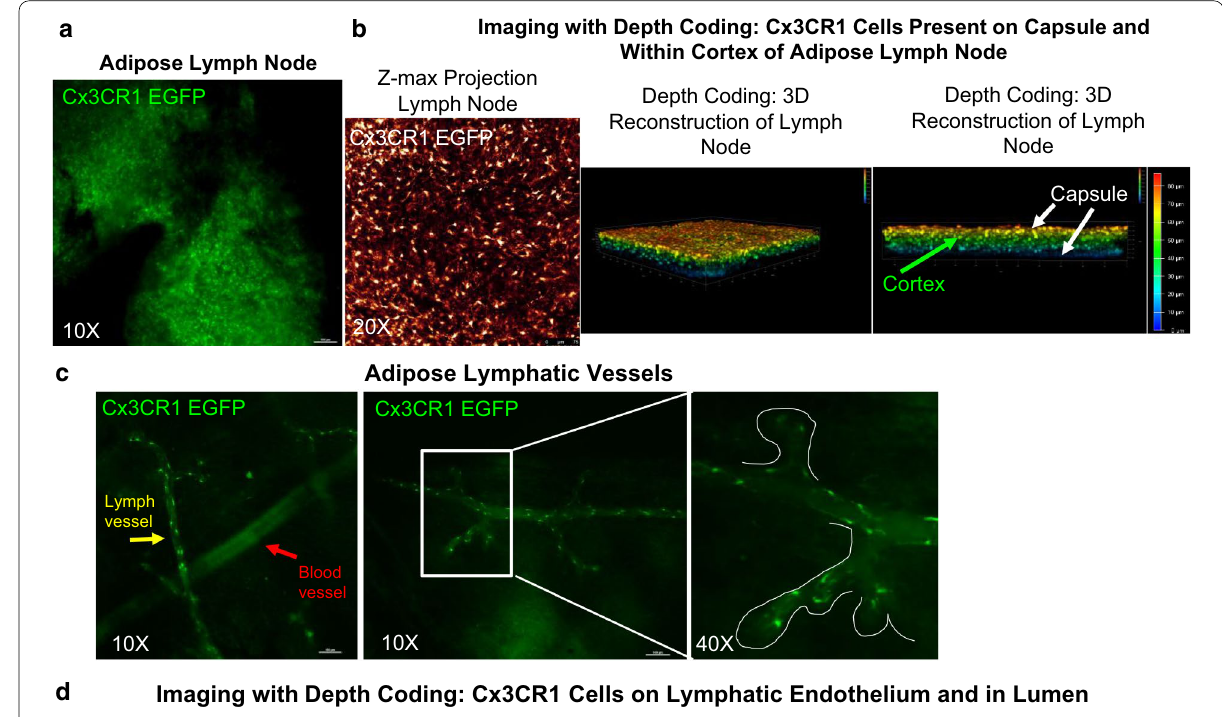
Depth Coding: 3D Reconstruction